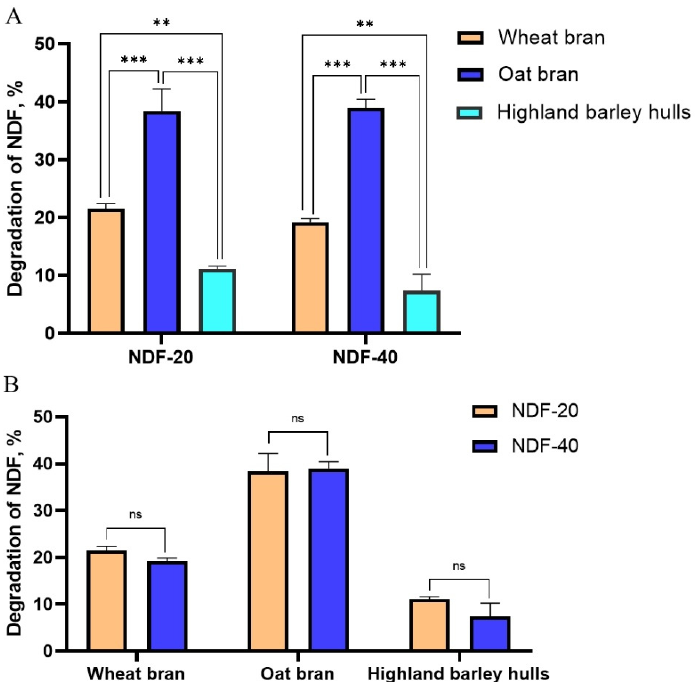
Figure 2. Comparison of degradation ability of Diqing Tibetan Pigs fecal microorganism to different types of fiber. ( A , B ) Wheat bran, oat bran, and highland barley hulls were selected as fermentation substrates, and feces from Diqing Tibetan pigs (the content of NDF in the feed are 20% and 40%, respectively) were selected as starter culture. * p < 0.05; ** p < 0.01, and *** p < 0.005. In addition, we observed the fecal microorganisms of DLY and Diqing Tibetan pigs by microscopy, and we found that the number of live bacteria was NDF-40, NDF-20, and DLY in descending order, and the microscopic morphology of fecal microorganisms of DLY were different from that of Diqing Tibetan pigs (Figure 3). The fecal microorganisms of DLY pigs were mainly in the form of short rods and single morphology, while the fecal microorganisms of Diqing Tibetan pigs were composed of cocci, short rods, and long rods, and the number was higher. Compared with NDF-20, the morphology of NDF-40 was similar, but the number of NDF-40 groups was more. It is suggested that the specific flora structure and quantity of manure microorganisms of Diqing Tibetan pigs is one of the important factors to ensure its high efficiency fiber degradation ability. Figure 3. Microscopic observation (400×) on fecal microorganisms of DLY and Diqing Tibetan pigs by crystal violet staining.